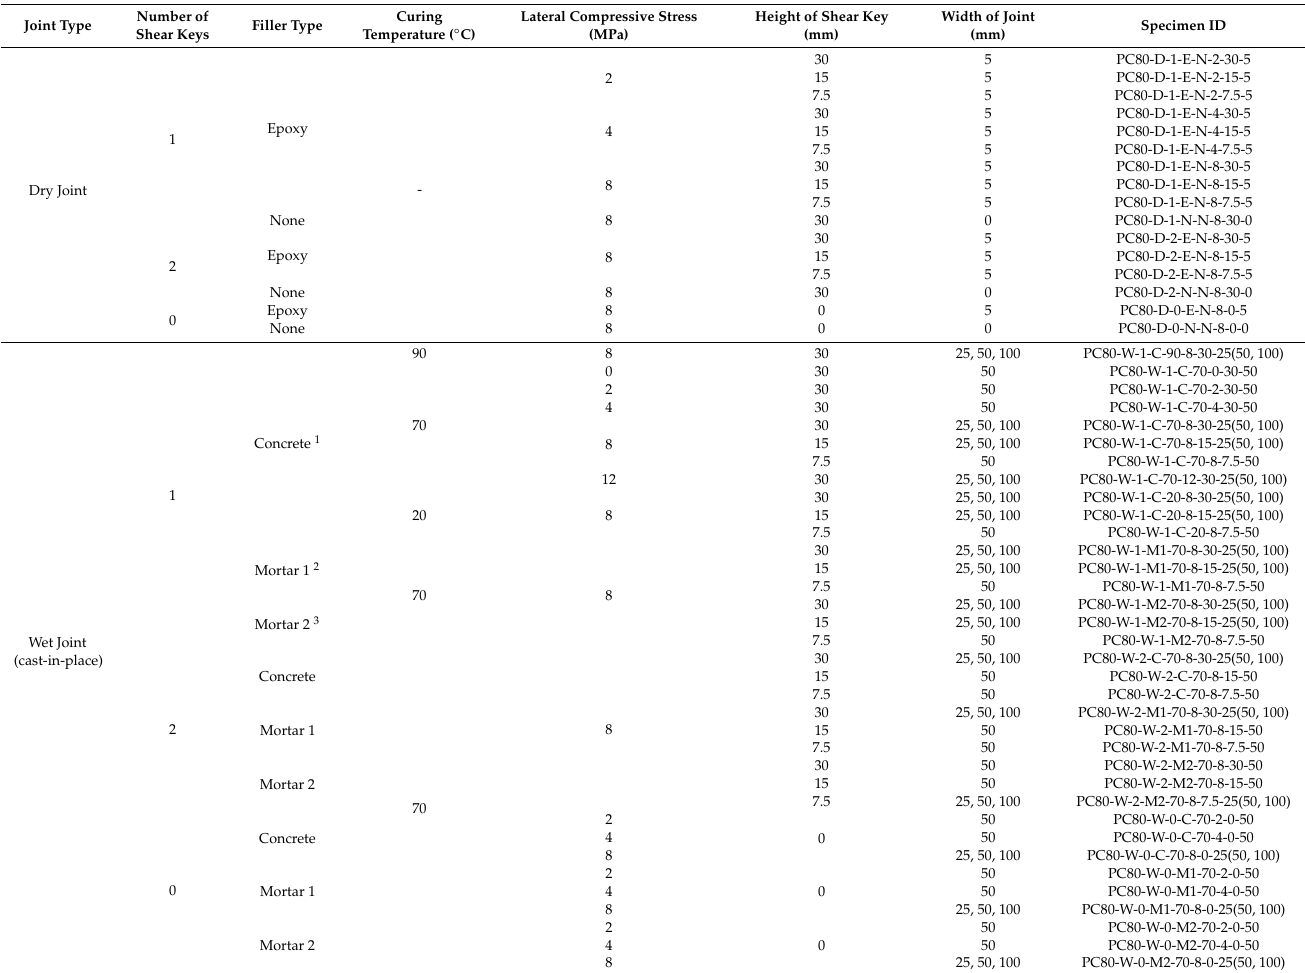
Table 2. Variables of push-o ff test ( f (cid:48) c = 80